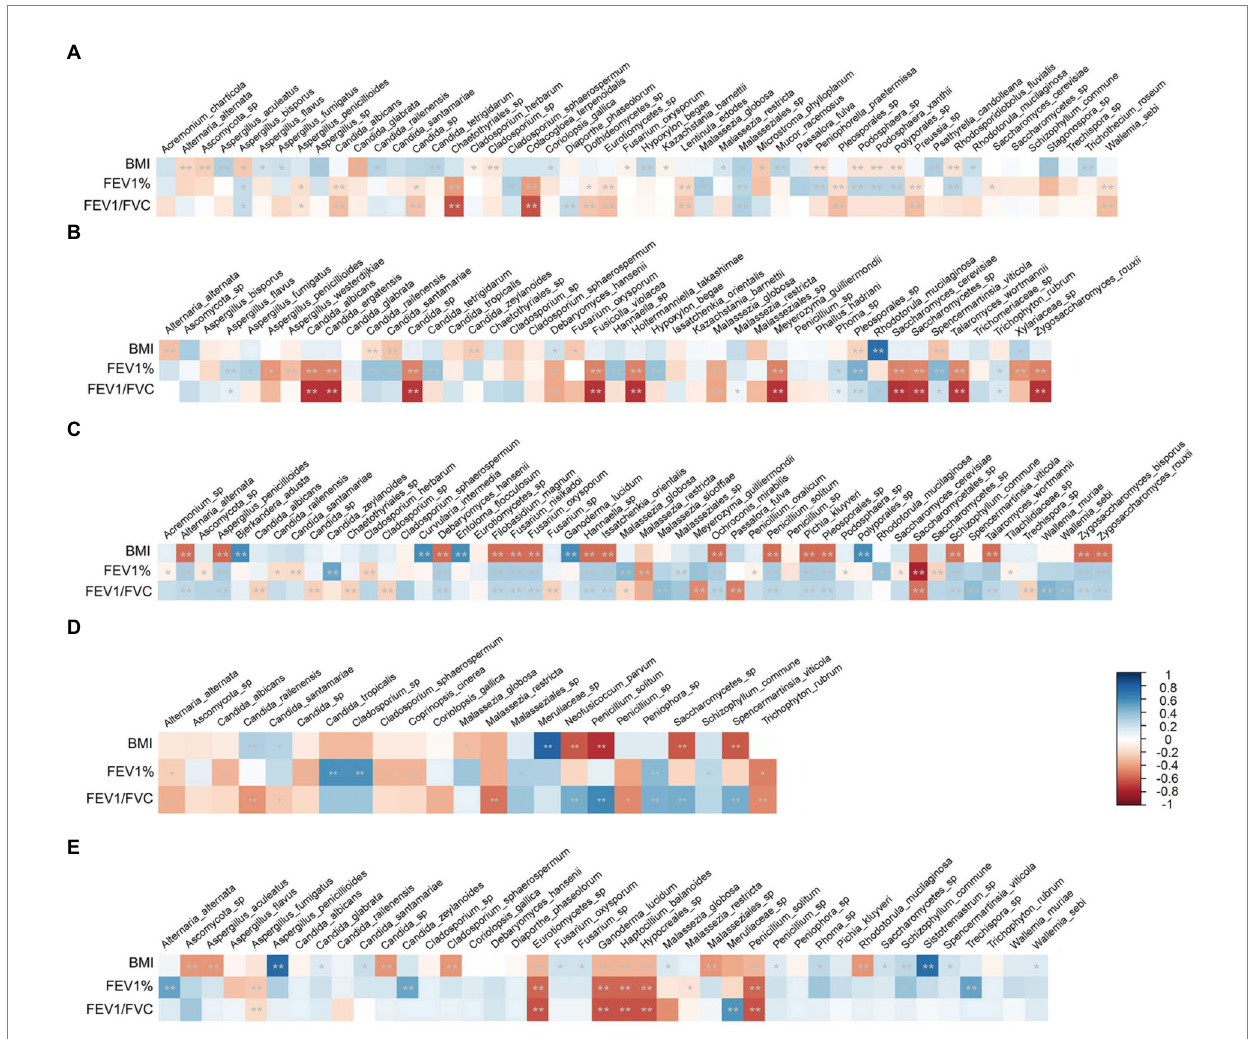
FIGURE 8 Relations between the patient characteristics and specific species in each disease group. (A) ILD group; (B) BP group; (C) FP group; (D) AS group; (E) LC group. Stars within heatmap boxes indicate significance (* p < 0.05, ** p <